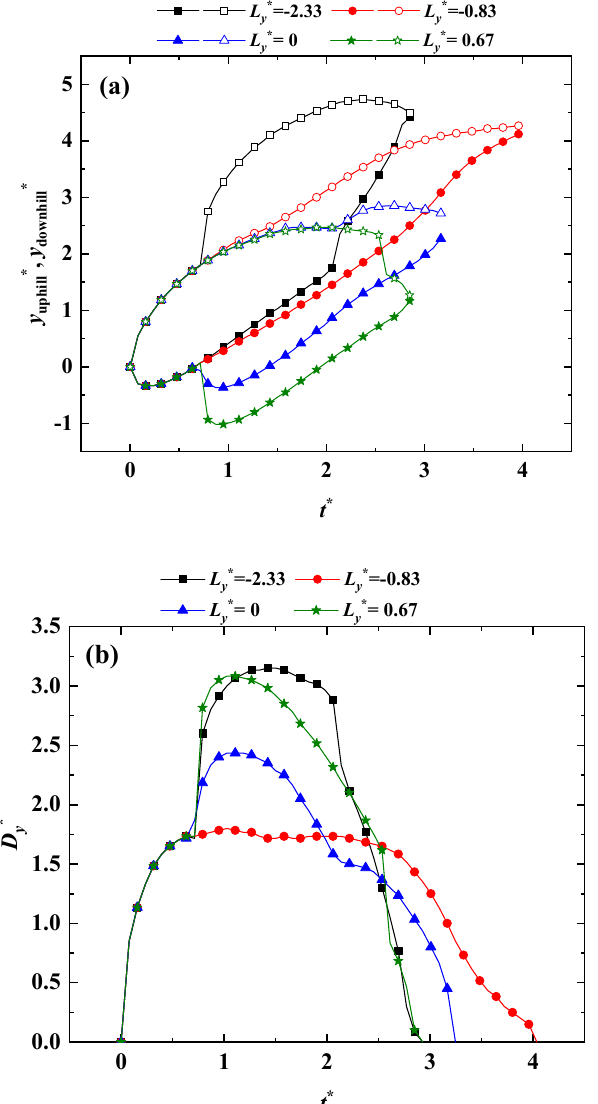
Figure 14. The evolutions of ( a ) y uphill *; y downhill *; ( b ) D y * with time at various L y *.